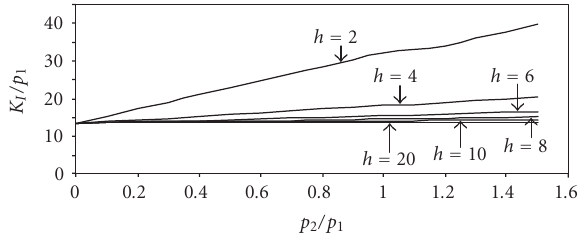
Figure 4.3 Plot of K I /p 1 versus p 2 /p 1 at x 0 /a = 0 . 6, c = 0 .